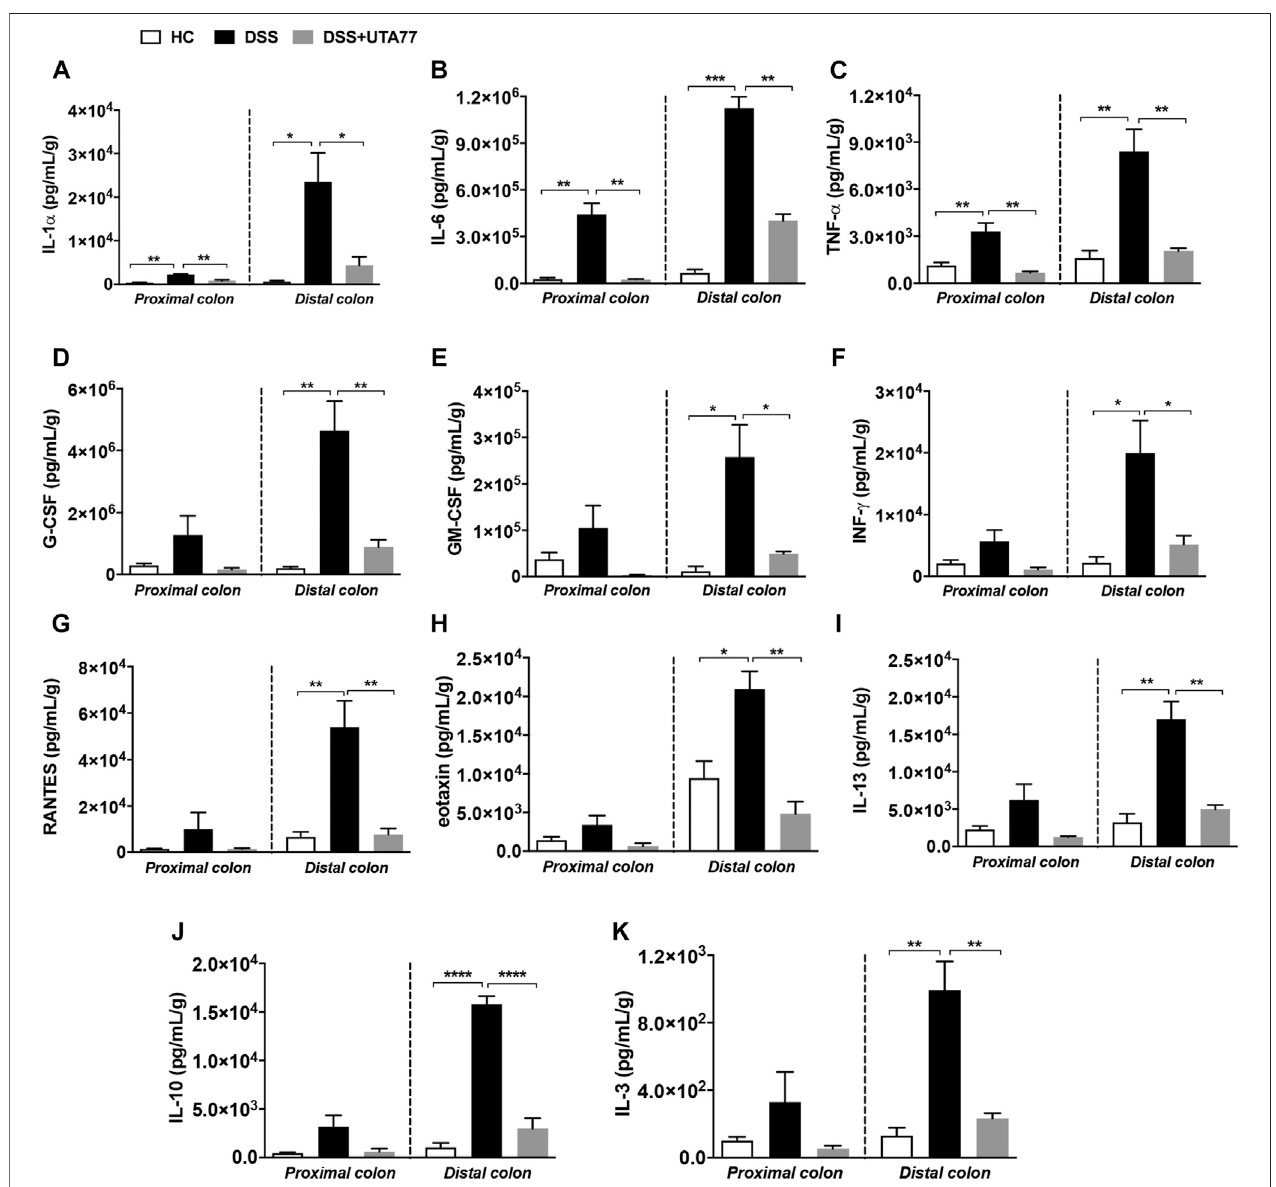
FIGURE 6 | Effect of UTA77 on the level of in fl ammatory cytokines and chemokines in colon tissue. Tissue levels of (A) IL-1 α , (B) IL-6, (C) TNF- α , (D) G-CSF, (E) GM-CSF, (F) INF- γ , (G) RANTES, (H) eotaxin, (I) IL-13, (J) IL-10, and (K) IL-3 in PC and DC were quanti fi ed by Bio-Plex assay. Data expressed as mean ± SEM ( n (cid:1) 3/ group) and statistical signi fi cance evaluated by one-way ANOVA followed by Tukey ’ s posttest where *p < 0.05, **p < 0.01, ***p < 0.001, and * ***p < 0.0001.